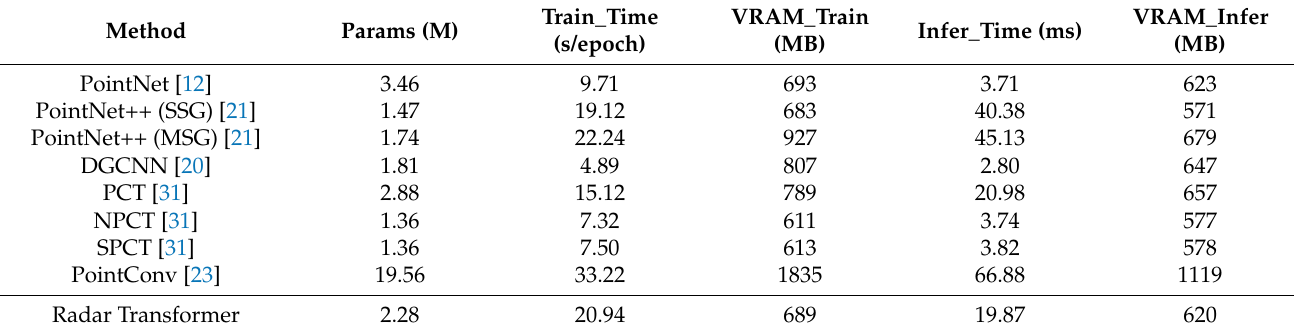
Table 4. Performance analysis of the proposed